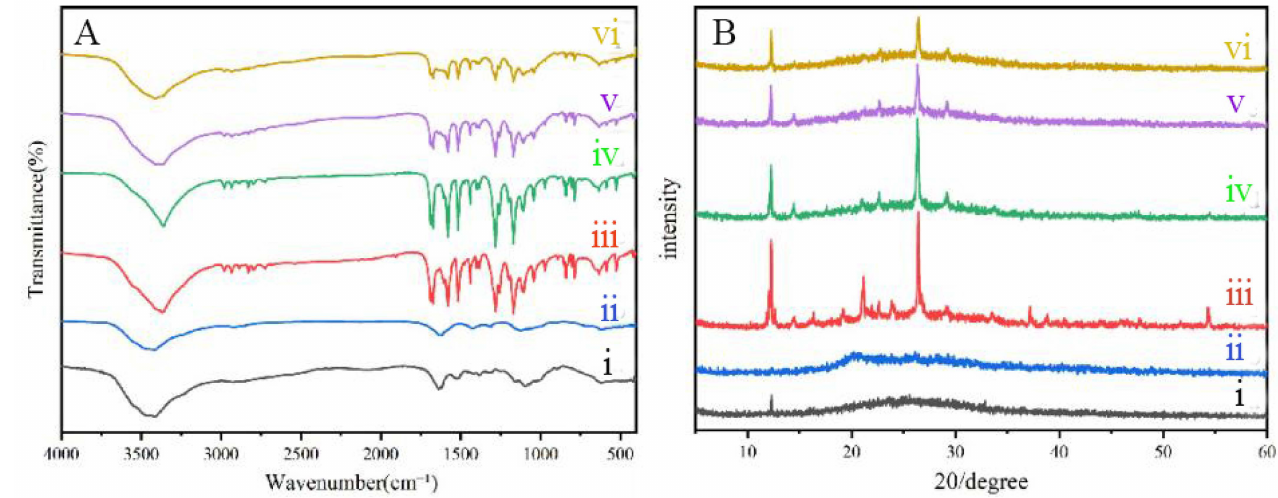
Figure 8. FT-IR ( A ) and XRD ( B ) of LMW CMCS (i), CMCS (ii), EVA (iii), CMCS/EVA dried gel (iv), EVA crystals (v, 25 ◦ C obtained) and EVA crystals (vi, 4 °C obtained). Detailed descriptions please see the